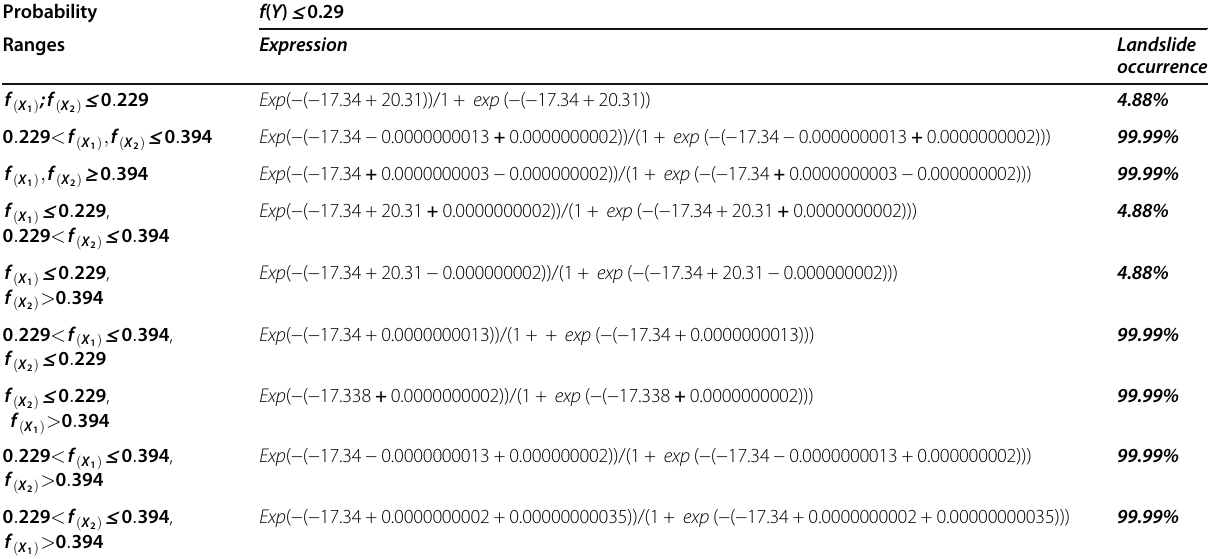
Table 5 Different probabilities expressed by the prediction model Probability f ( Y ) ≤ 0.29 Ranges Expression Landslide